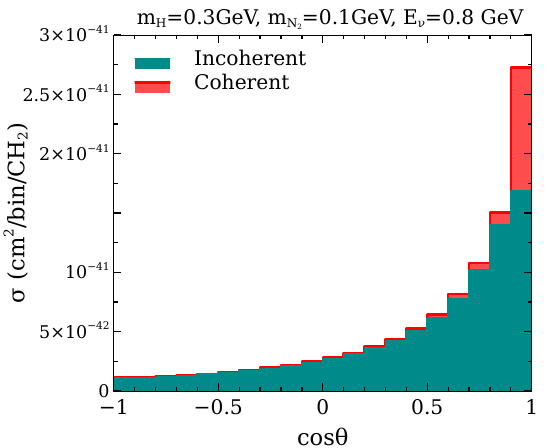
Figure 4. Angular variation of the total cross section with an intermediate mass scalar. Both coherent and incoherent contributions are